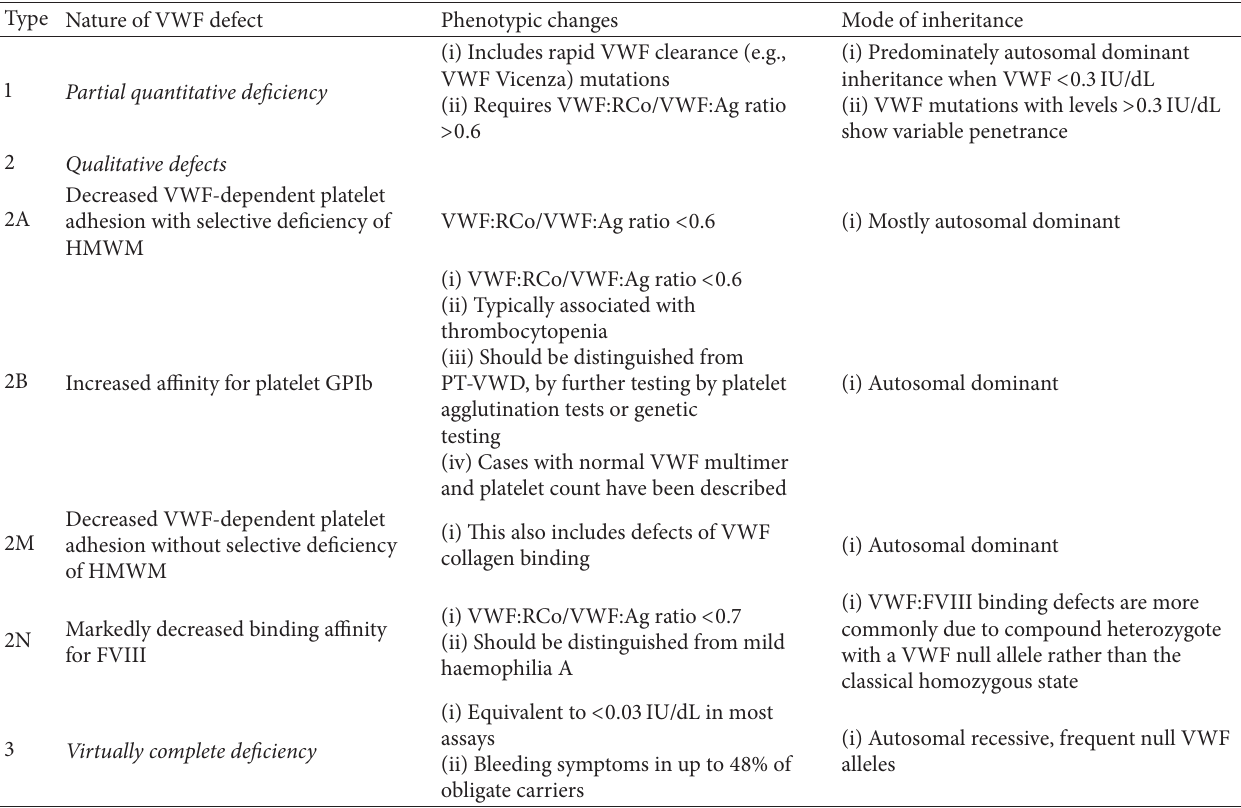
Table 1: Classification of VWD (adapted from Laffan et al.